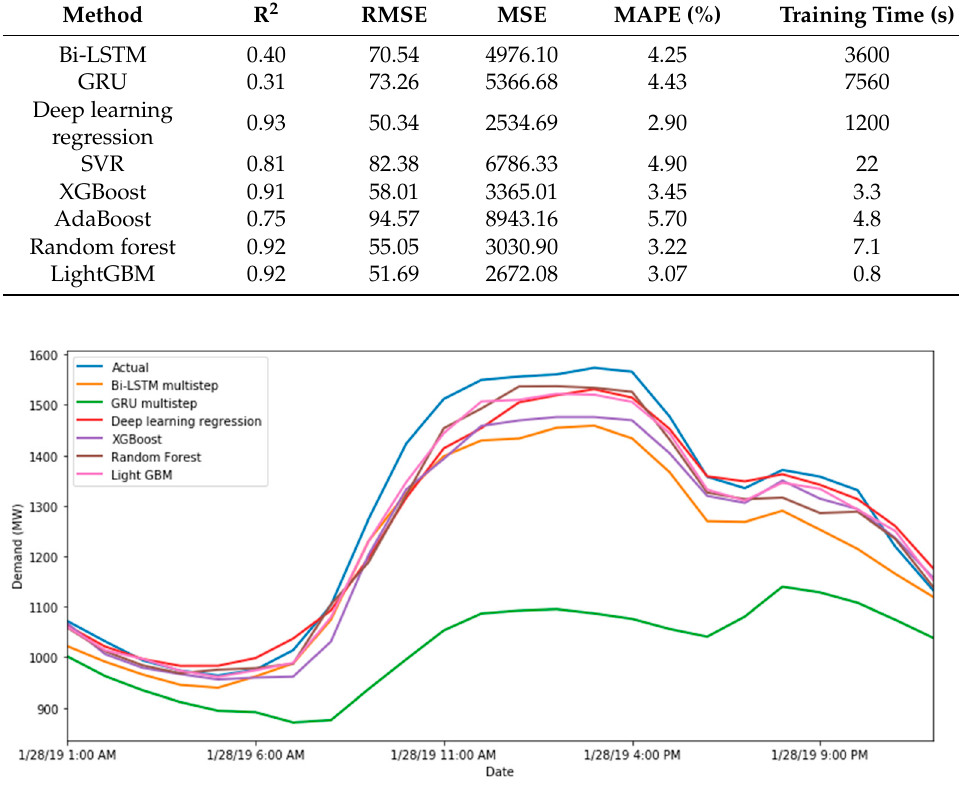
Figure 11. Performance on the Models on the test